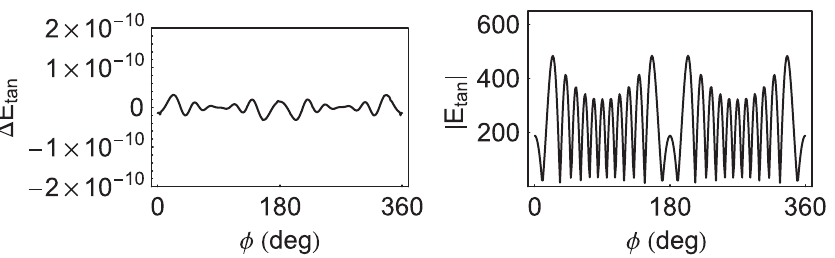
(cid:2) E (cid:5) a (cid:4) (cid:10) (cid:6) (cid:4) E (cid:5) a (cid:7) (cid:10) (cid:6) , around the great circle circumference of the tan tan tan p (cid:5) ^ z (cid:4) ^ x (cid:6) . The frame on the right shows the 2